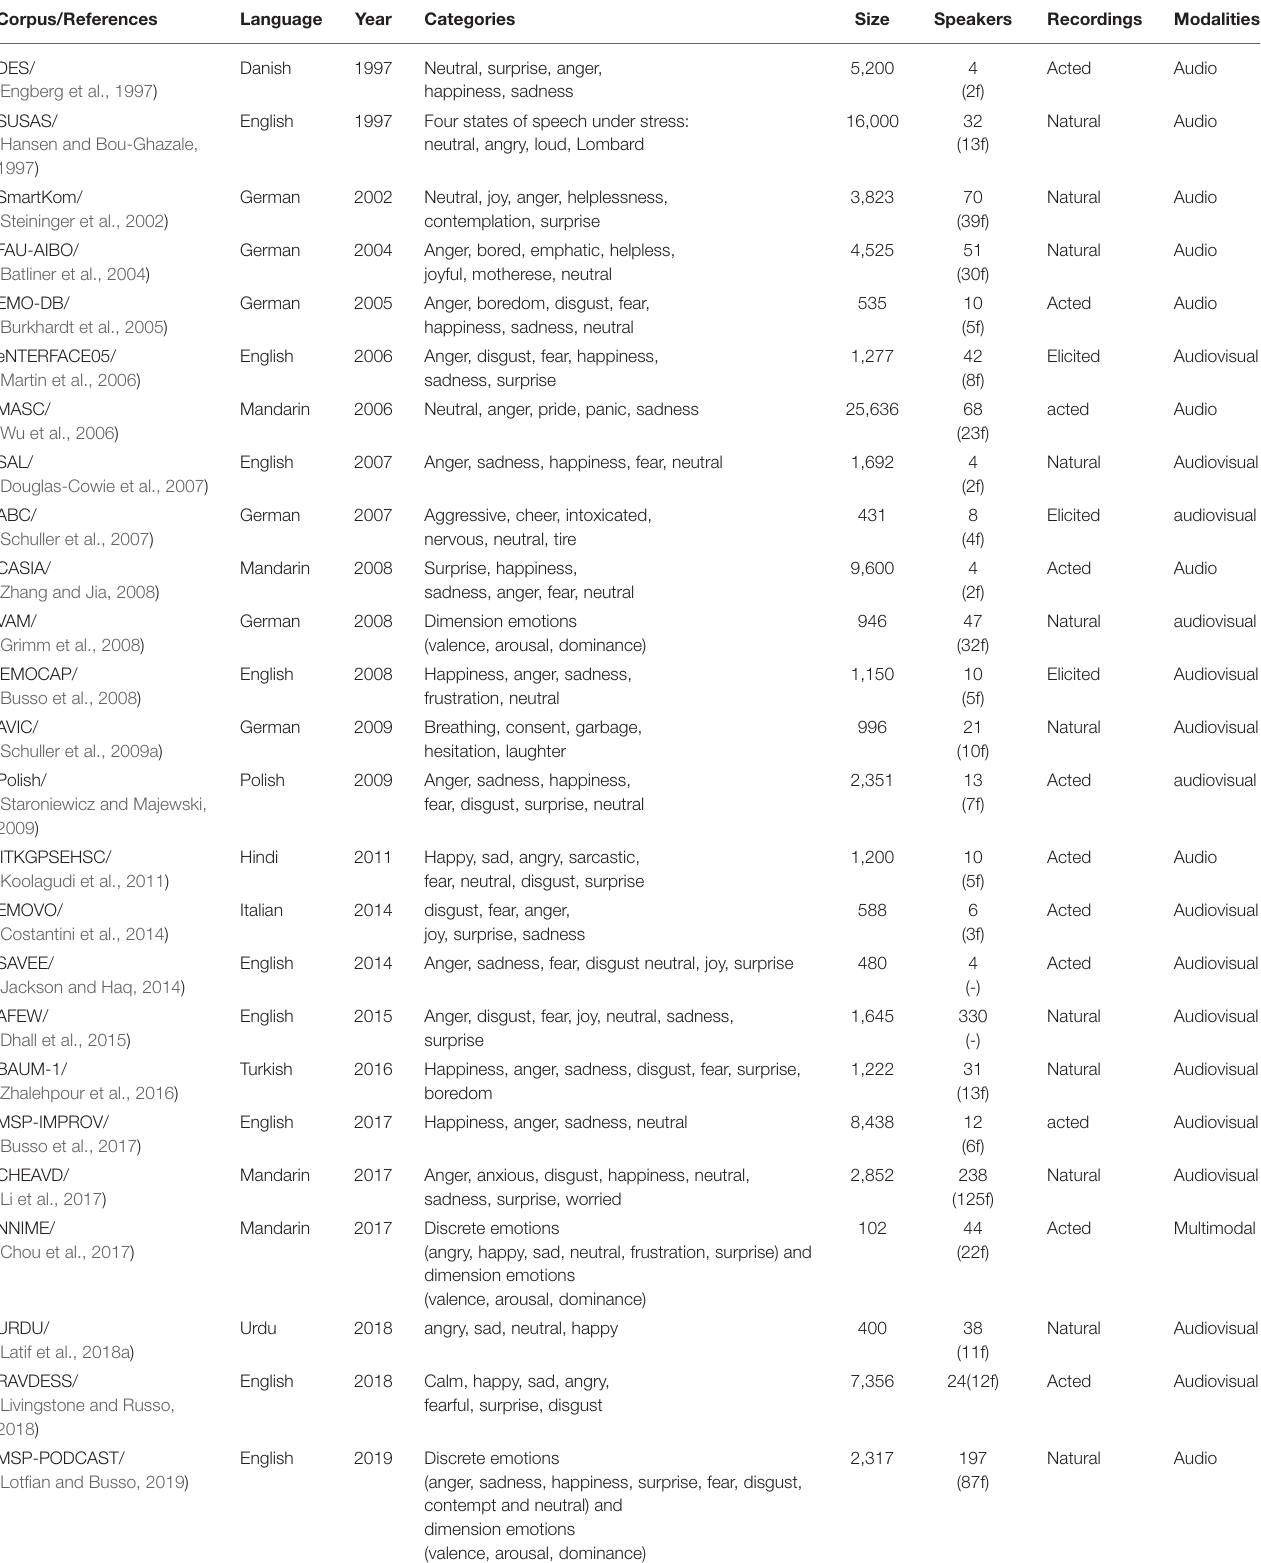
TABLE 1 | A brief summary of speech emotion